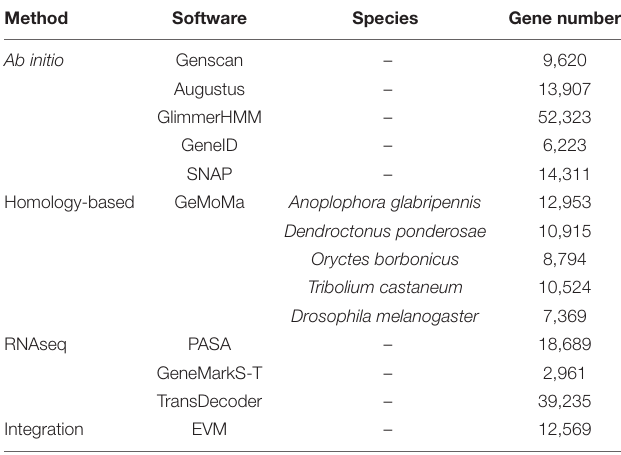
TABLE 1 | Summary of C. buqueti genome annotation.